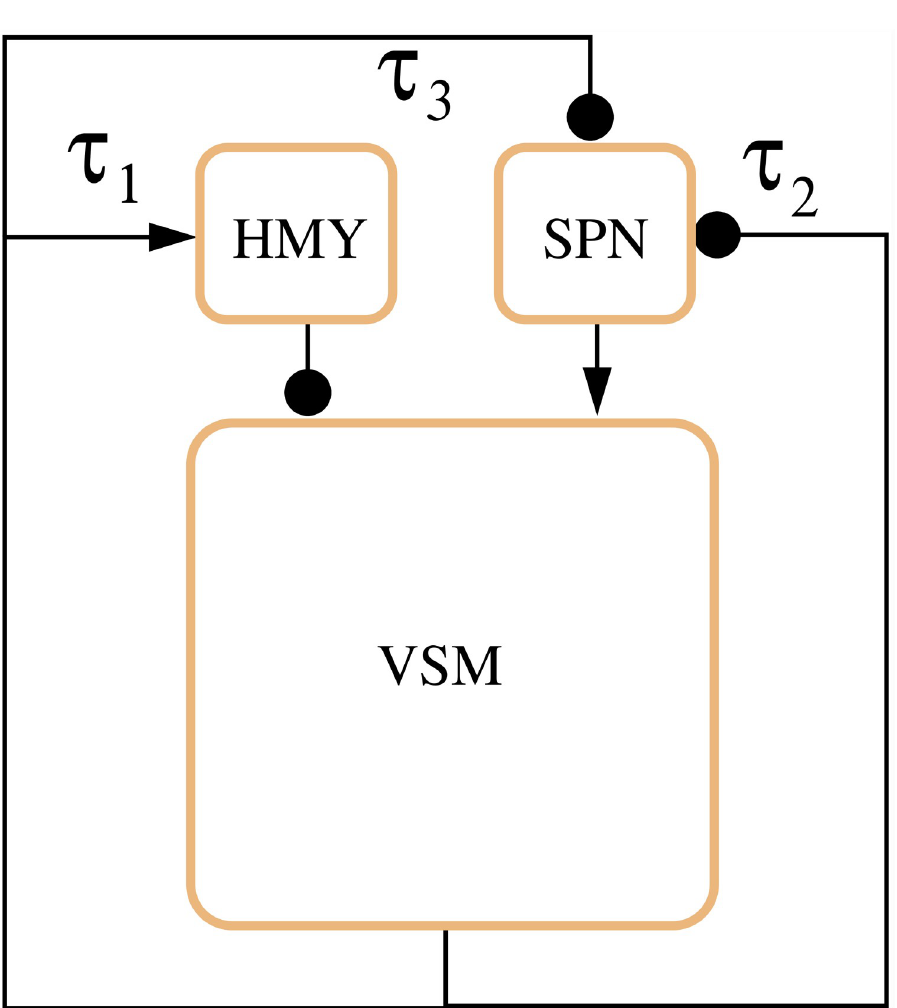
Fig 4. Visual representation of the reduced system in Eqs